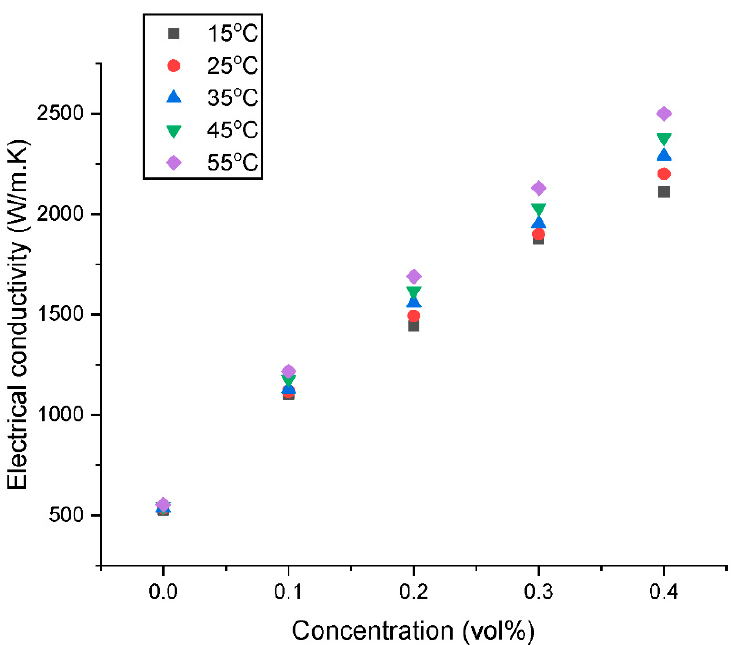
Figure 13. Influence of temperature on the electrical conductivity of the hybrid nanofluids at various concentrations.